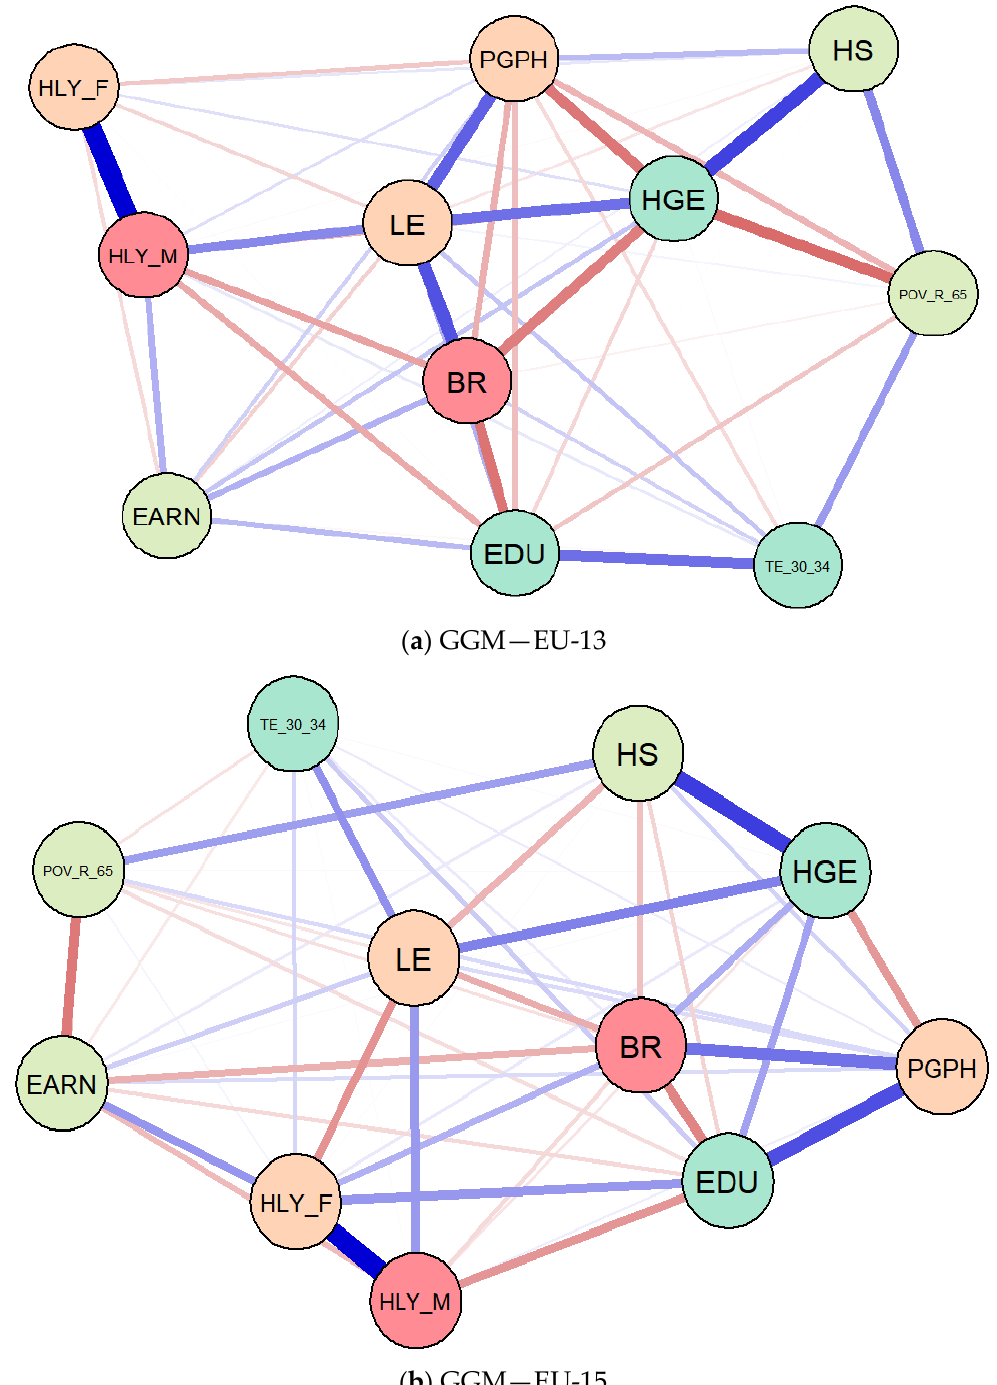
Figure 6. Results of Gaussian graphical models (GGMs), Extended Bayesian Information Criterion with graphical least absolute shrinkage and selection operator (EBICglasso) method, EU-13 ( a ) and EU-15 ( b ). Source: authors’ contribution in R programming version 3.6.3. (R Foundation, Free Software Foundation’s GNU General Public License, Boston, MA,